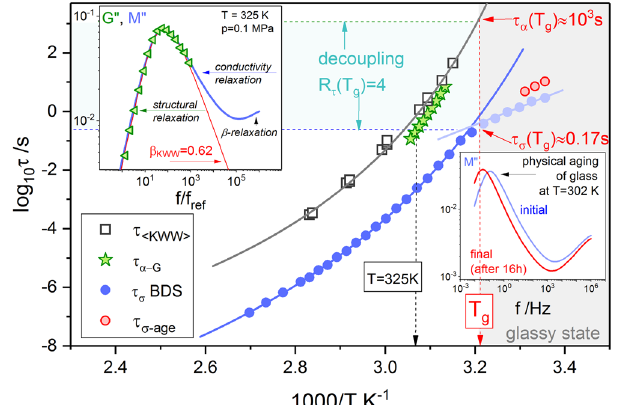
Figure 2. Relaxation map of ACB-HCl constructed using the data measured at ambient pressure conditions. The upper inset present the comparison of M ″ ( f ) and G ″ ( f ) spectra collected at 325 K. In the lower inset the evolution of conductivity relaxation spectra during physical aging at 302 K is